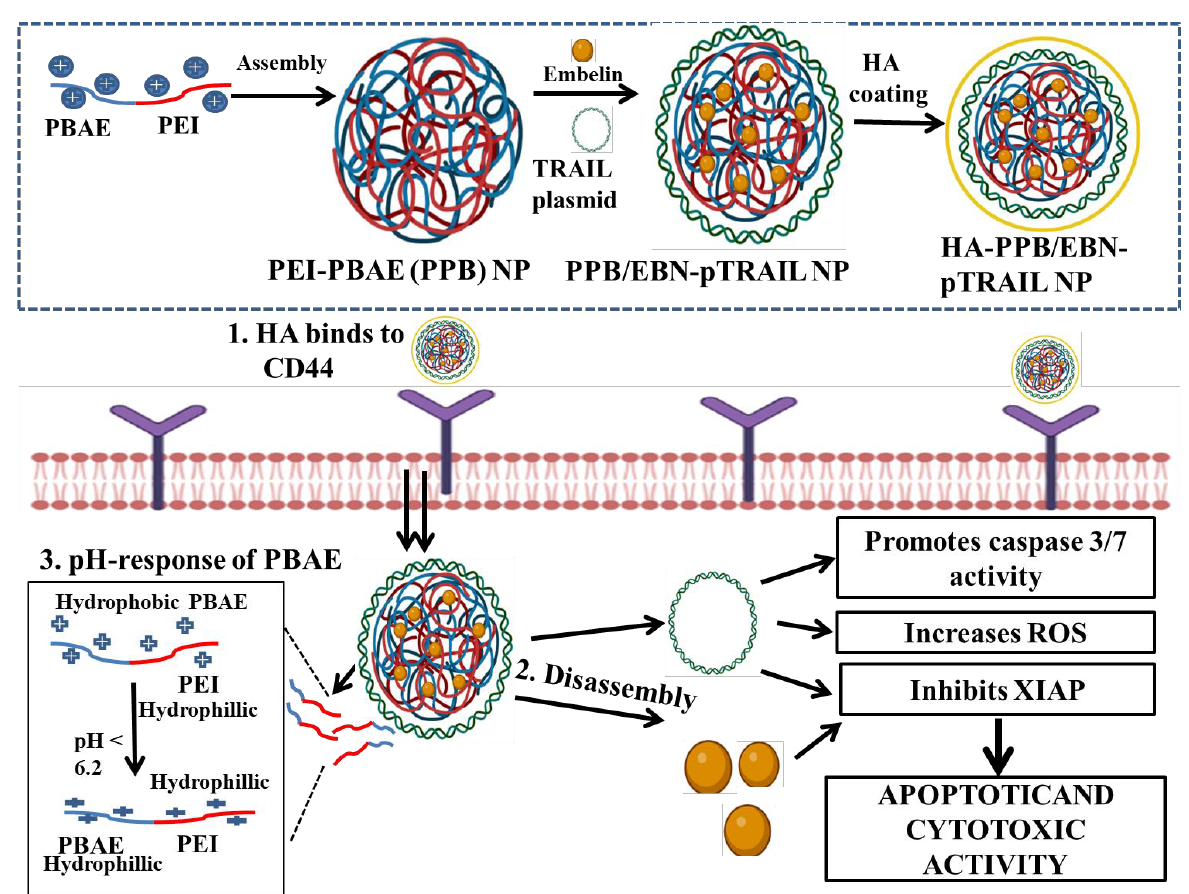
Figure 1. Schematic representation of the anti-cancer activity of embelin and TRAIL-encapsulated, hyaluronic acid-coated, PBAE–PEI nanoparticles (HA-PPB/EBN-pTRAIL NP). The co-delivery of TRAIL and embelin prompted caspase 3/7 activity, elevated the level of ROS and suppression of apoptosis-related protein.